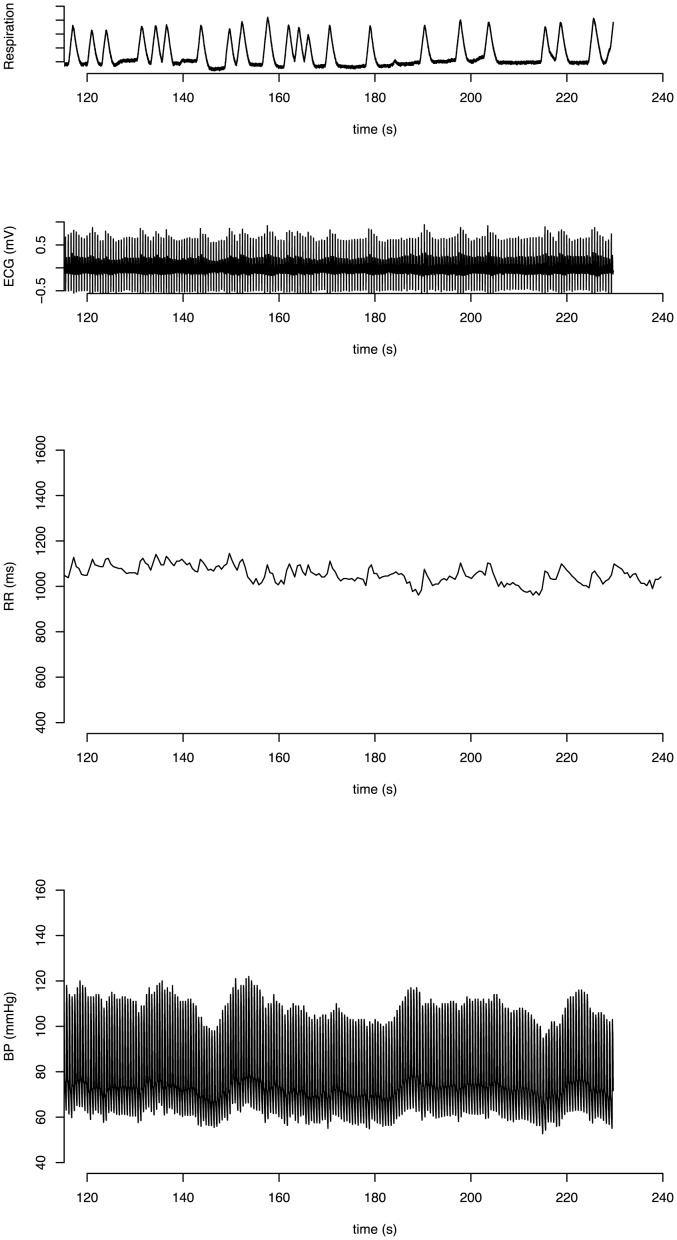
Random-frequency paced breathing.Respiration, ECG, RR interval and blood pressure recording during the random-frequency breathing protocol in a representative subject. Random-frequency breathing was used to broaden the frequency content of the respiratory signal for transfer function analysis.